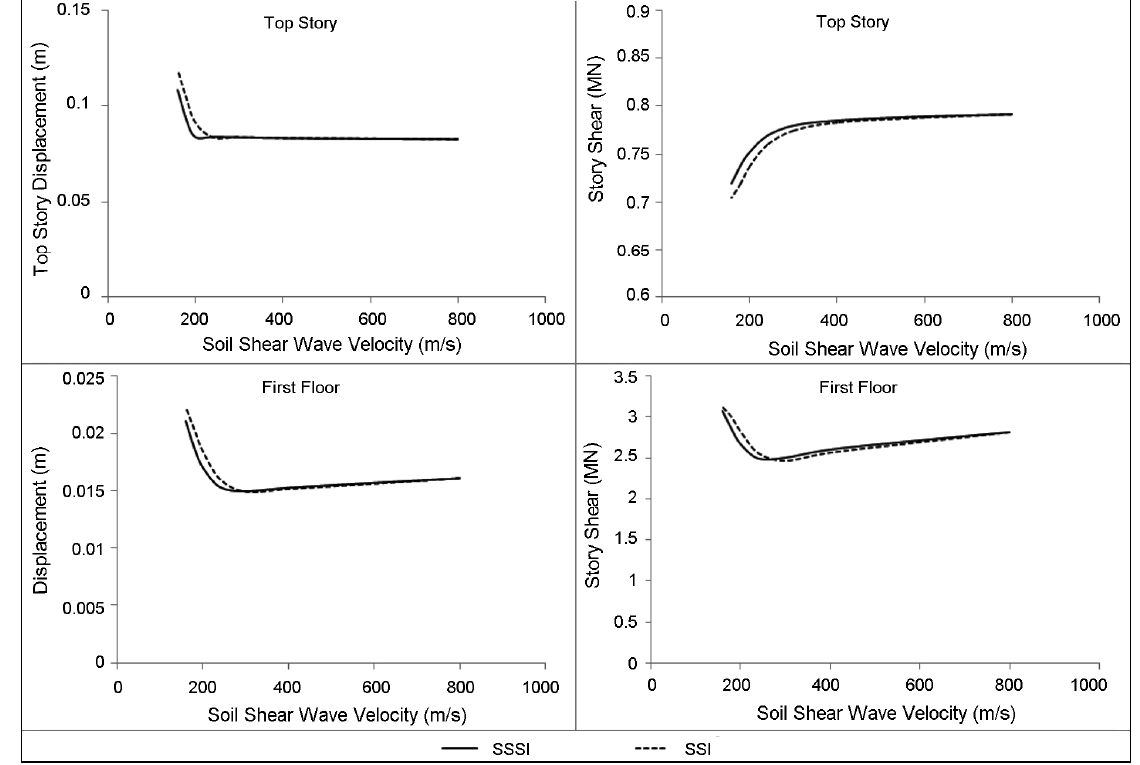
Fig. 7. Maximum story responses versus soil shear wave velocity